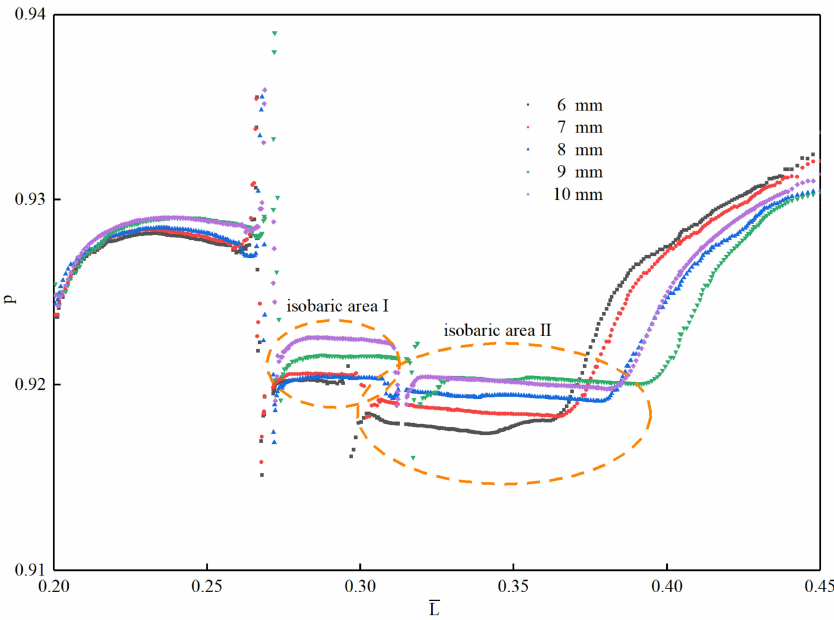
Figure 20. Distribution of surface pressure along vehicle’s axial